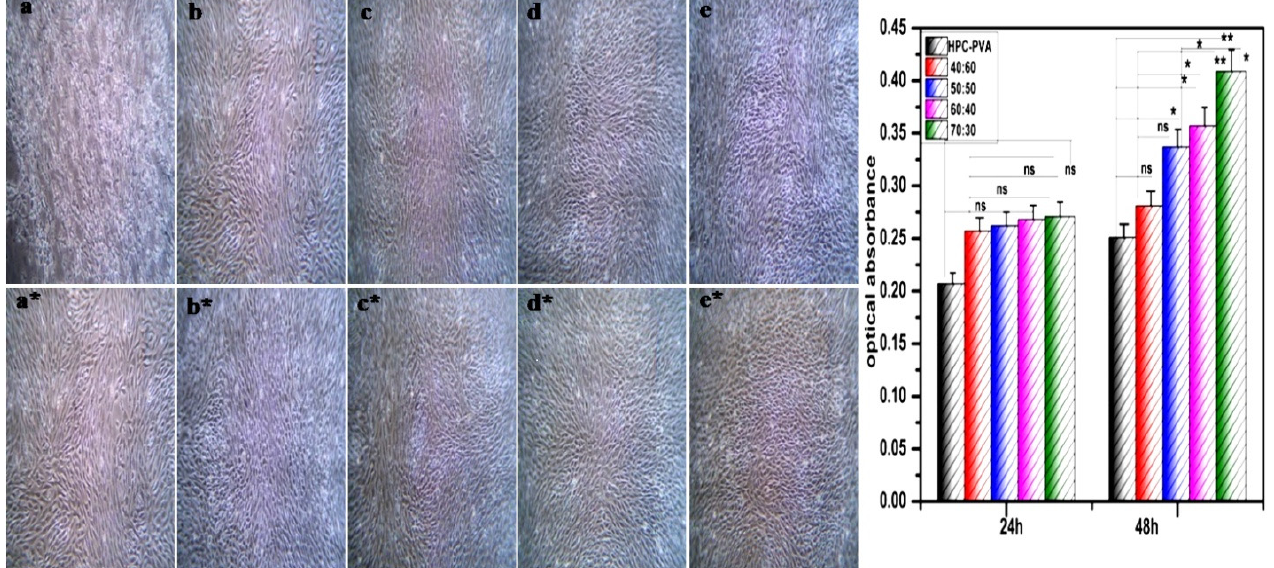
Figure 8. Cytotoxicity of electrospun nanofibrous ( a – e ) (24 h) and ( a* – e* ) (48 h) ( a ) HPC/PLA ( b ) 40:60 ( c ) 50:50 ( d ) 60:40 ( e ) 70:30 of HAP-HPC/PLA and its significant difference.